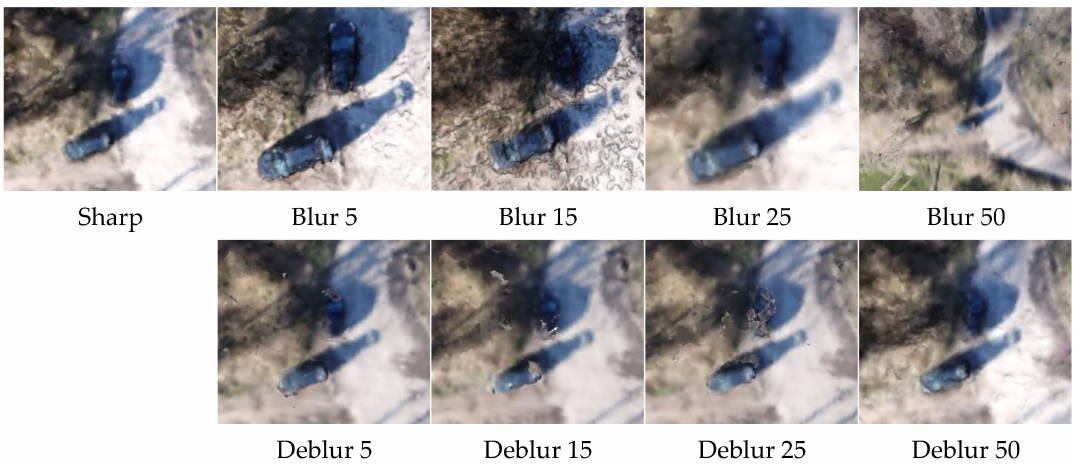
Figure 8. Textured model—visual comparison of the product part developed using photos with a varying blur kernel and their corresponding product, after the application of the method.